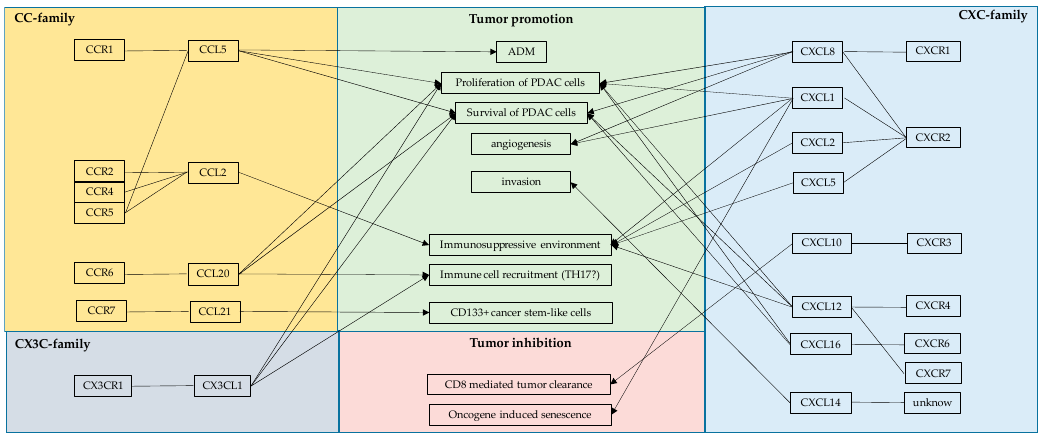
Figure 1. Schematic representation of the NF- κ B/chemokine interactions in PDAC. Illustration of the interaction of the chemokines with their receptors (left and right) and the resulting effect on the tumor (middle).